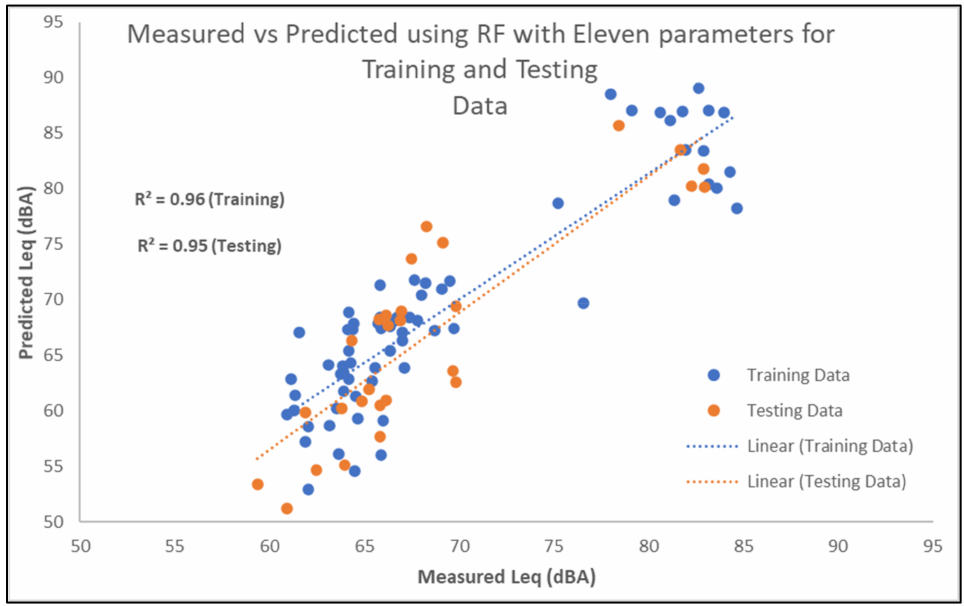
Figure 11. Scatter plot of L eq (measured vs predicted) using Random Forest for training and testing dataset with eleven